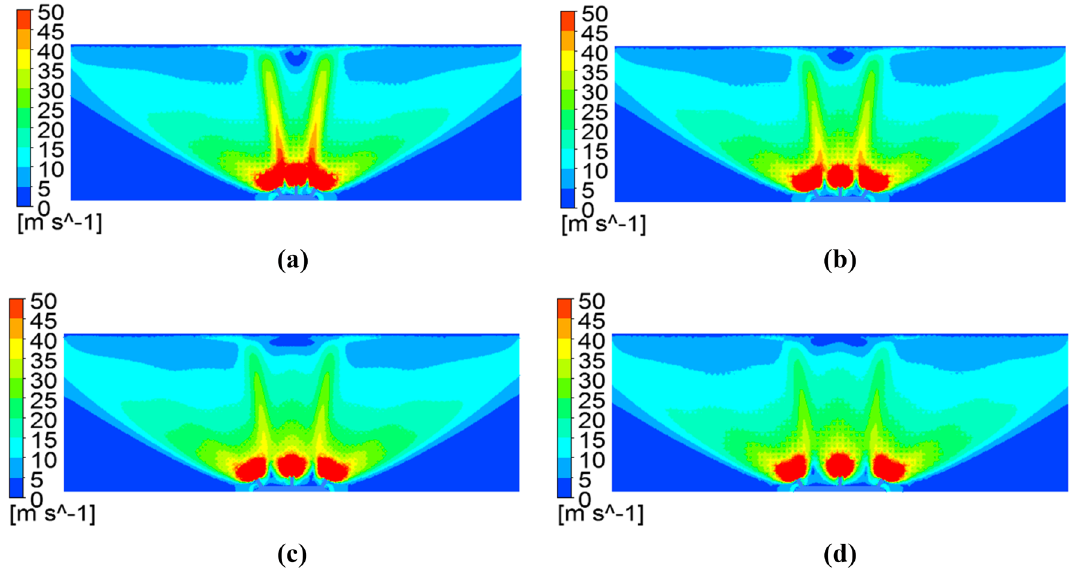
Fig. 5 Velocity contours at section X = 0 for different L when θ = 30°: a L = 20 mm; b L = 30 mm; c L = 40 mm; d L = 50 mm